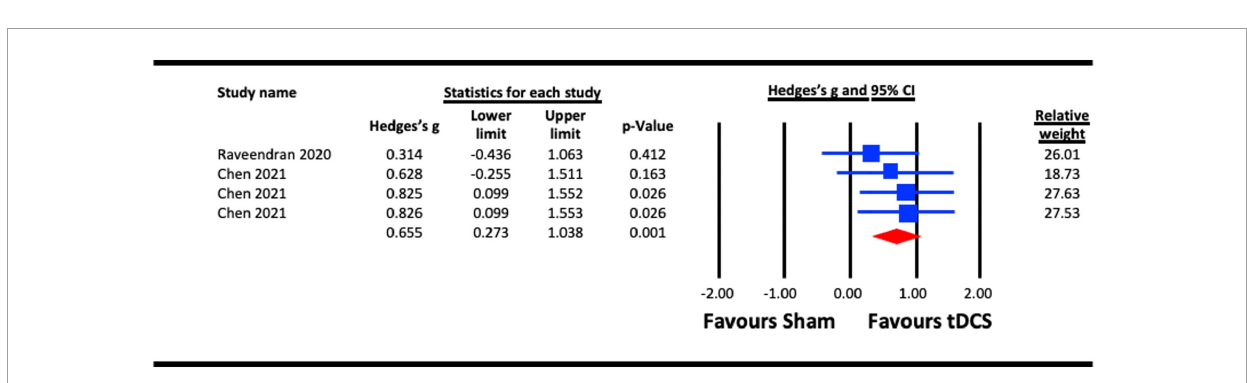
FIGURE7 Acute effect of anodal-transcranial direct current stimulation (a-tDCS) on crowding. Chen (2021) (each line represents the outcome of experiments 1–3).